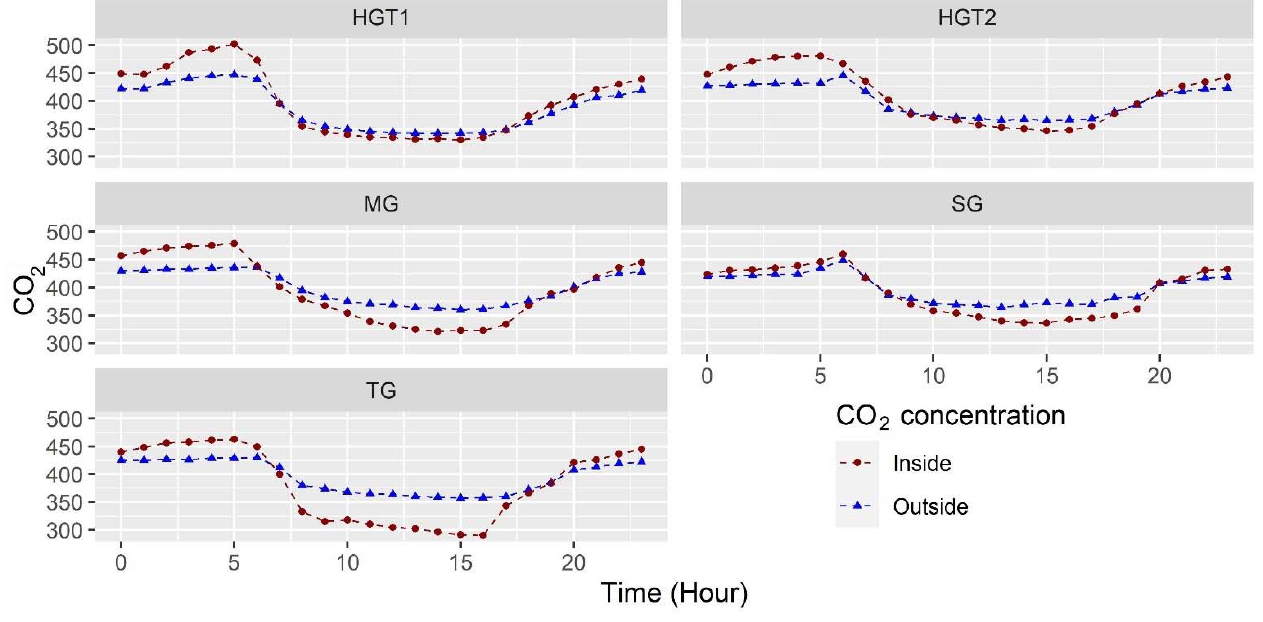
Figure 5. Mean CO 2 concentration behavior for the sensor in the indoor environment and mean outdoor CO 2 concentration for each of the greenhouses evaluated.